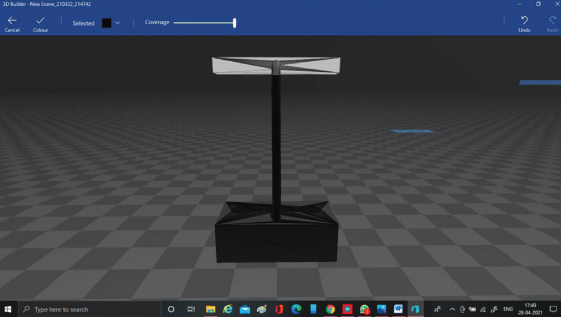
Figure 15: Back view of the body.